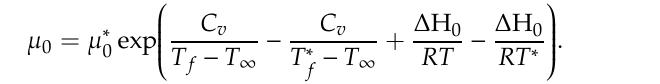
Figure 8. Isometric stress-temperature plot between a temperature range of 130–150 ◦ C, at a strain rate of 1 s − 1